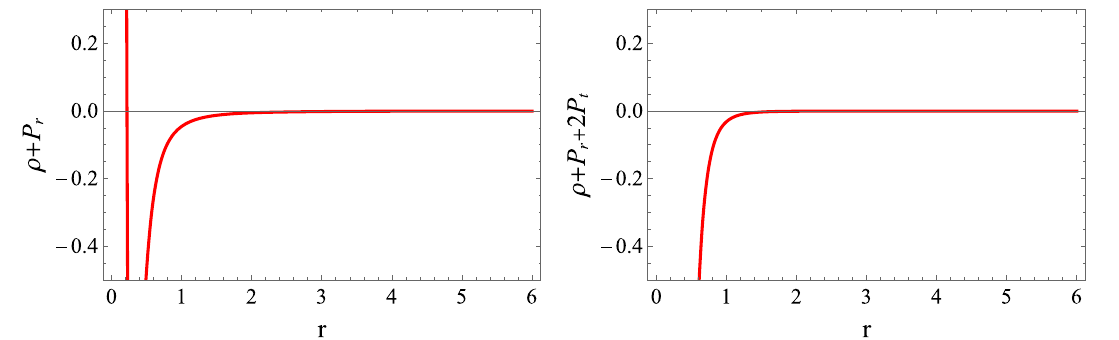
Fig. 5 The behavior of NEC and SEC diagrams have been plotted for the isotropic wormhole against r . Here also NEC is violated, this implies WEC is also violated. For plotting the constants are α = 0 . 1 and r 0 = 1 along with ω t = 0 . 5